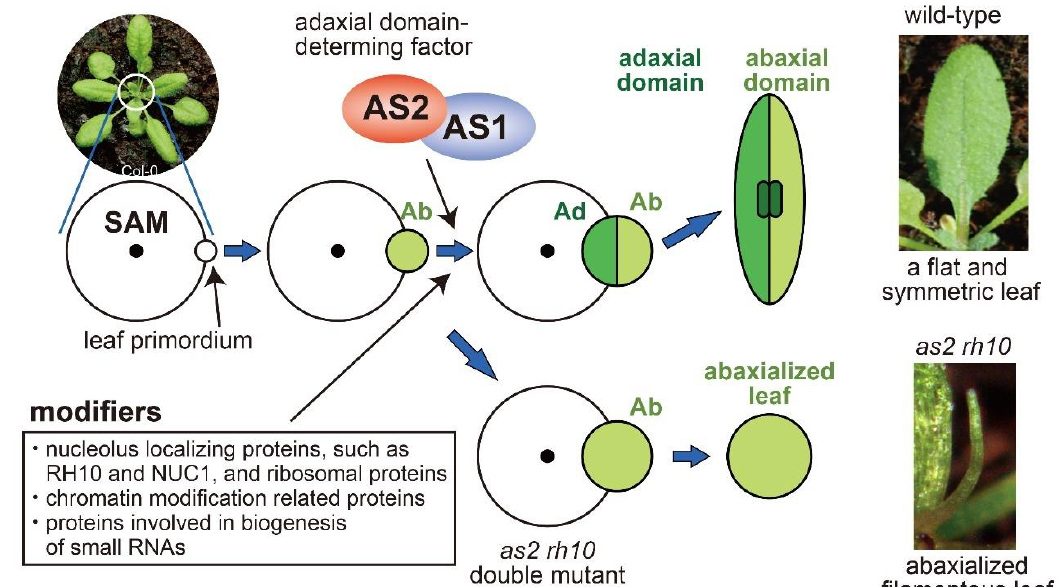
Figure 3. Development of leaves along with three axes. Top views of SAM are schematically shown by open circle. Dot indicates the center of the SAM. Adaxial and abaxial domains are shown by green and light green, respectively. AS2-AS1 contributes to the determination of adaxial domain followed by the medial-lateral growth of leaves with vasculature (indicated by dark green rectangles). Modifiers act cooperatively with AS2–AS1 at leaf primordia to develop the adaxial (Ad) domain from abaxialized (Ab) leaf primordia and to generate leaves with a flat and symmetric structure. The double mutation into AS2 (or AS1) and modifiers results in the production of abaxialized filamentous leaves. Photograph of wild-type leaf is modified from ref. [64]. Table 1. Gene mutations that act as modifiers to enhance leaf adaxial–abaxial abnormalities in as2 and as1 .